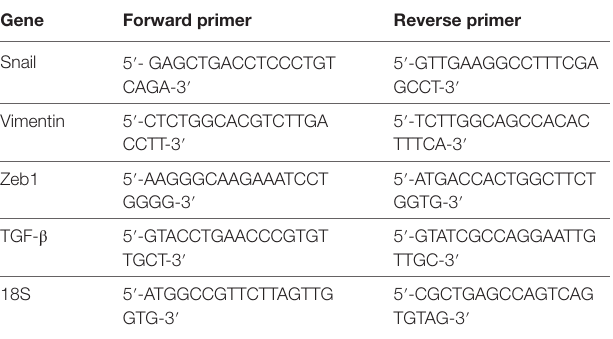
Table 1 | Target genes and terminal primers used in the qPCR